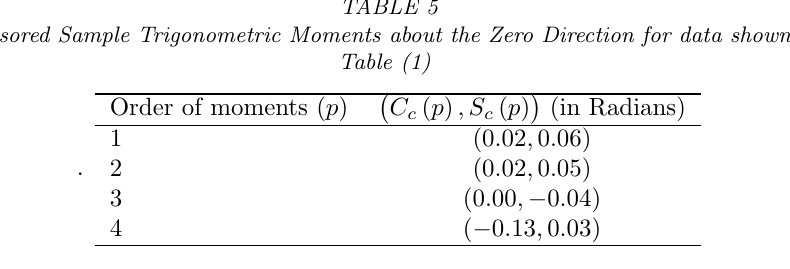
Censored Sample Trigonometric Moments about the Mean Direction for data shown